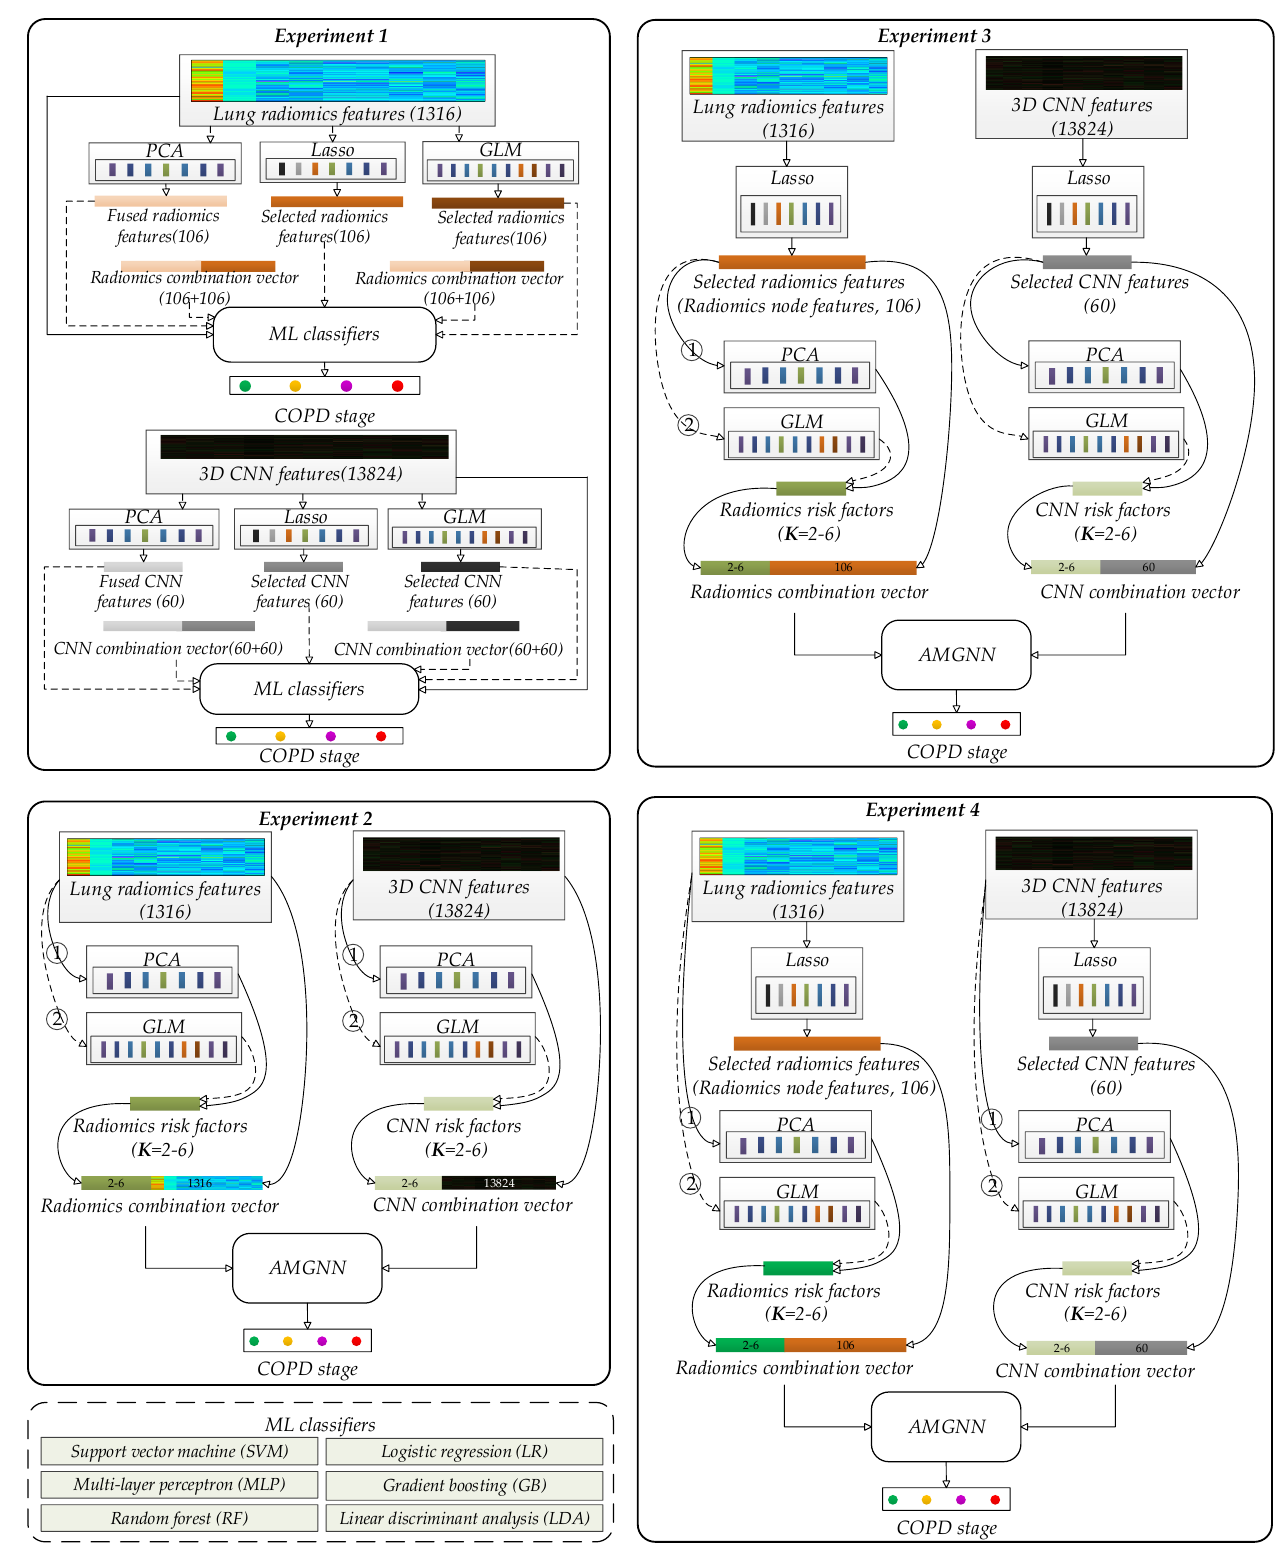
Figure 3. Experimental design in this paper.